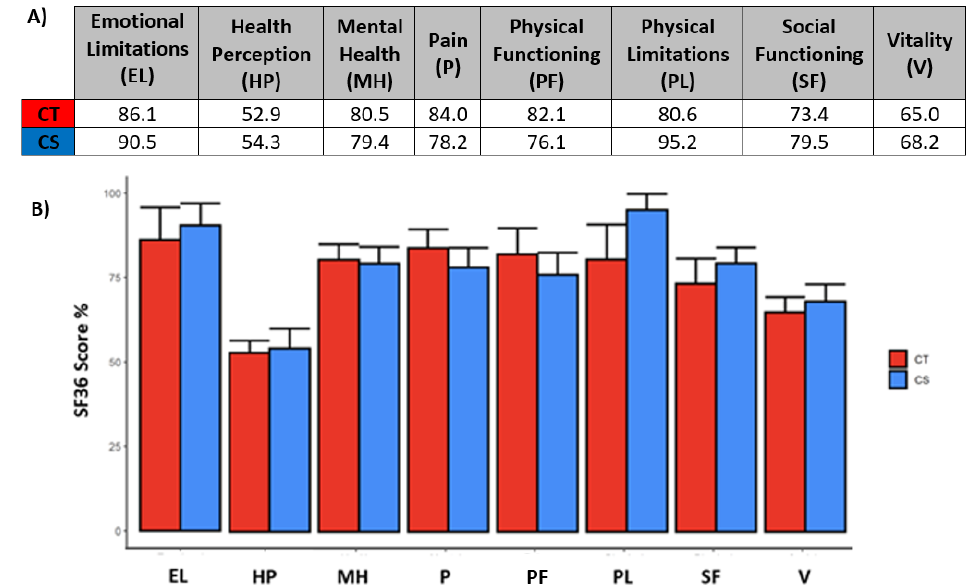
Figure 2. ( A )—Numerical values for the 8 scales in the QoL SF36 shown in Figure 2B. ( B )—Quality of life score evaluated through SF36 questionnaires for the 8 domains of the exam: 1. EL Emotional Limitations; 2. HP: Health Perceptions; 3. MH: Mental Health; 4. P: Pain; 5. PF: Physical Functioning; 6. PL: Physical Limitations; 7. SF: Social Functioning; 8. V: Vitality.